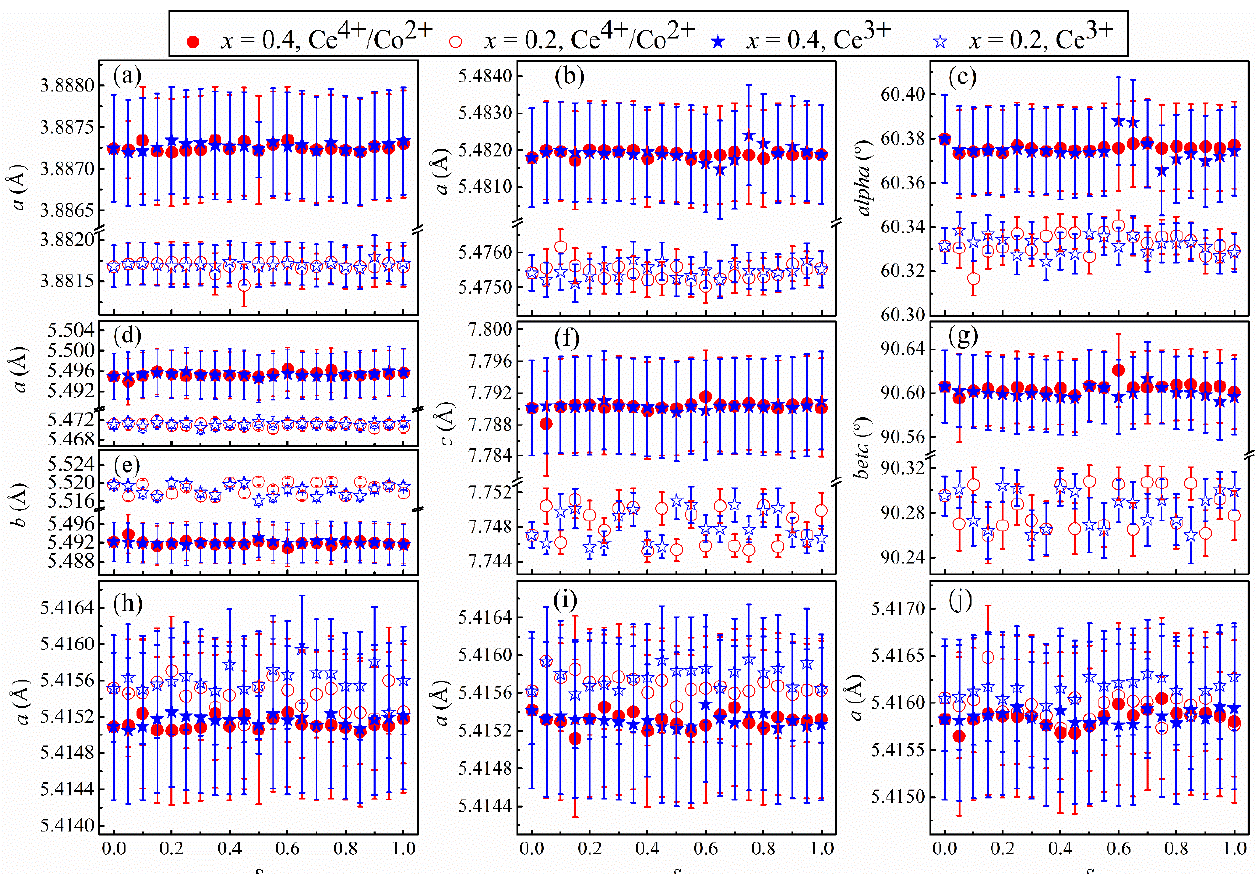
Figure 3. Lattice parameters refined from XRD data for La 1 − x Ce x CoO 3 with x = 0.2 and x = 0.4, considering two cases of cerium dopants as either Ce 3+ or Ce 4+ /Co 2+ . ( a – g ) Lattice parameters of the main phase with a lattice model of ( a ) cubic, ( b , c ) rhombohedral, and ( d – g ) monoclinic. ( h – j ) Lattice parameters of the secondary phase, CeO 2 , where ( h ) the main phase is cubic, ( i ) the main phase is rhombohedral, and ( j ) the main phase is monoclinic.